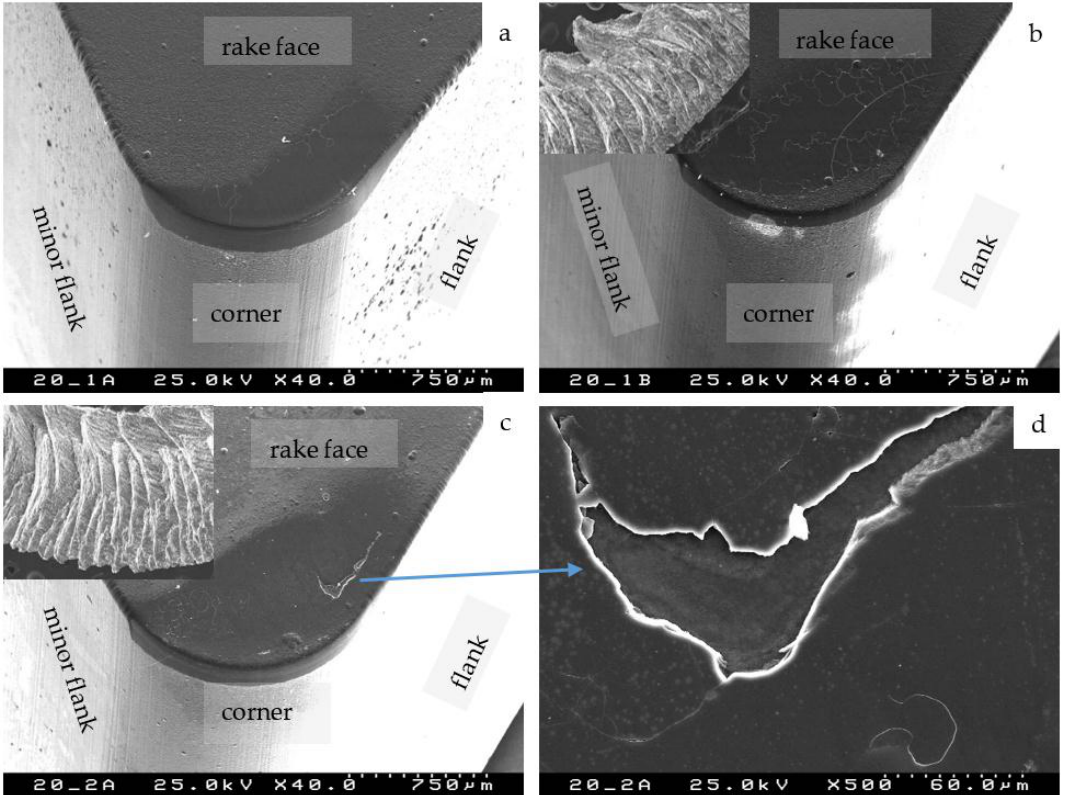
Figure 4. ( a ) SEM micrographs of ML10x2 cutting inserts after machining at v = 500 m·min −1 and DOC = 1.0 mm: ( a ) f = 0.1 mm·rev −1 , L = 1708 m; ( b ) f = 0.4 mm·rev −1 , L = 422 m. After machining at v = 750 m·min −1 , DOC = 1.0 mm, f = 0.4 mm·rev −1 , L = 413 m ( c , d ). Inset SEM micrographs of turning chips